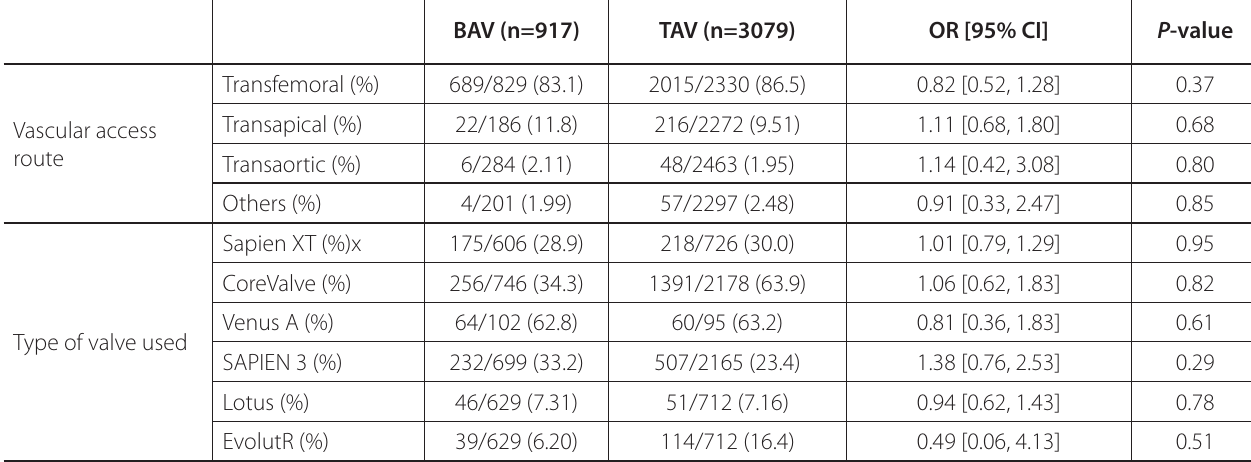
Table 4 . Operative outcomes of the included patients. The first number is the number of patients with the event or the sample mean value ± standard deviation of the variable, and the second is the number of patients for whom the event was described. Statistically significant differences were marked with an asterisk (*).